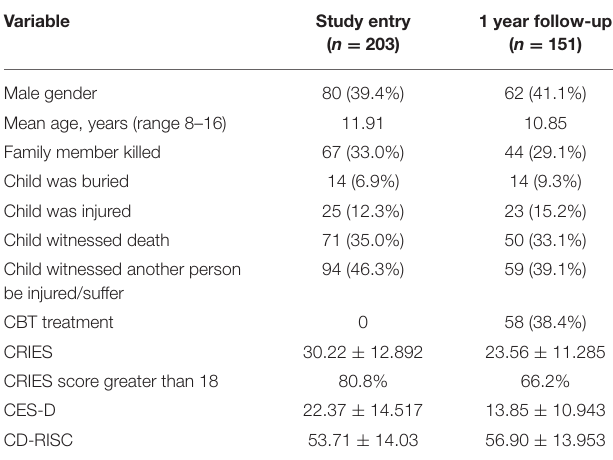
TABLE 1 | Description of the sample